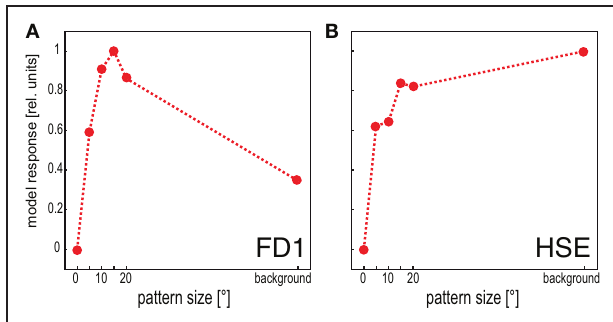
FIGURE 4 | Dependence of the mean response of the model FD1 and the model HSE on pattern size. Vertical cylinders with different diameters were moved within the receptive fields of the model cells to determine the responses to pattern size. The background response was obtained by moving the entire background around the model fly. (A) The model FD1 reached its largest mean response for objects with a limited extent. Motion of the entire background led to smaller responses. (B) The model HSE reached large responses for objects. However, its responses were largest when it was stimulated by motion of the entire